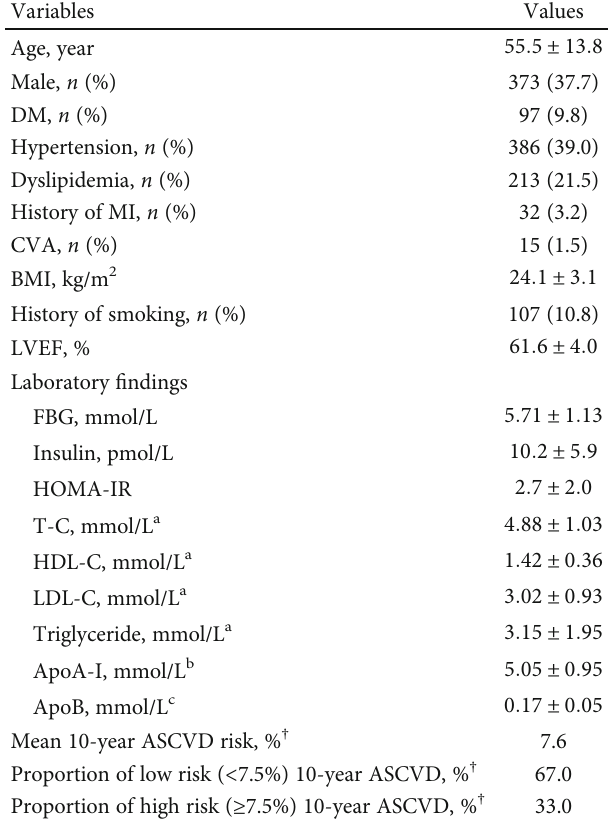
Table 1: Baseline characteristics of the entire study population. Variables